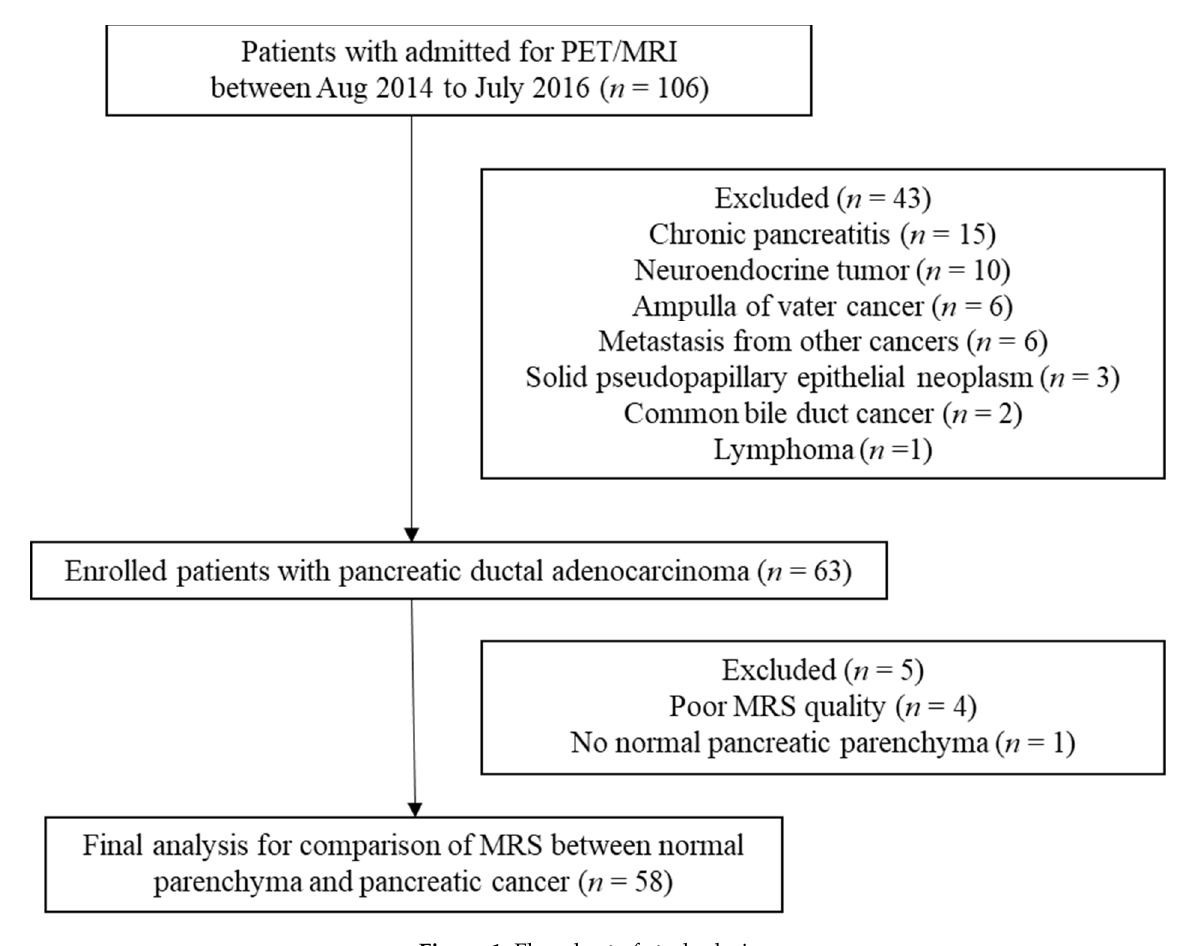
Figure 1. Flowchart of study design. Table 1. Demographic and clinical characteristics of the 58 participants.